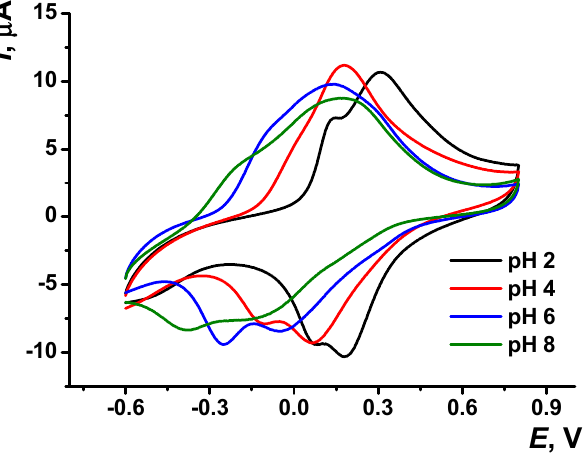
Figure 6. Cyclic voltammograms recorded on GCE covered with poly(Azure A/Chl), 0.1 M phosphate buffer containing 0.1 M NaNO 3 ; scan rate 100 mV/s.